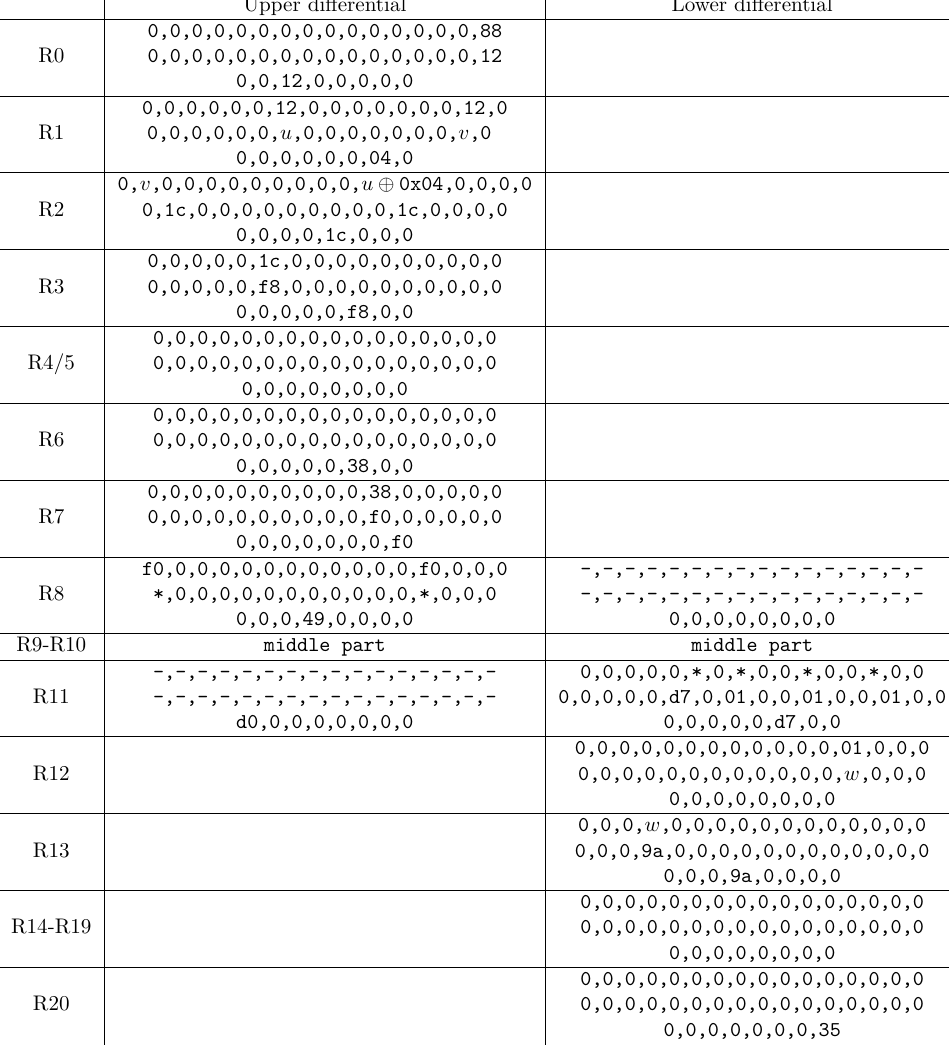
Table 20: The differentials of the 21-round distinguisher for ForkSkinny-128-256 , where R8 to R11 is r = 4-round middle part, u satisfies DDT[ 0xbe ][ u ] > 0 and m DDT[ u ⊕ 0xc6 ][ 0x2b ] > 0, v satisfies DDT[ 0xbe ][ v ] > 0 and DDT[ v ][ 0x2b ] > 0,